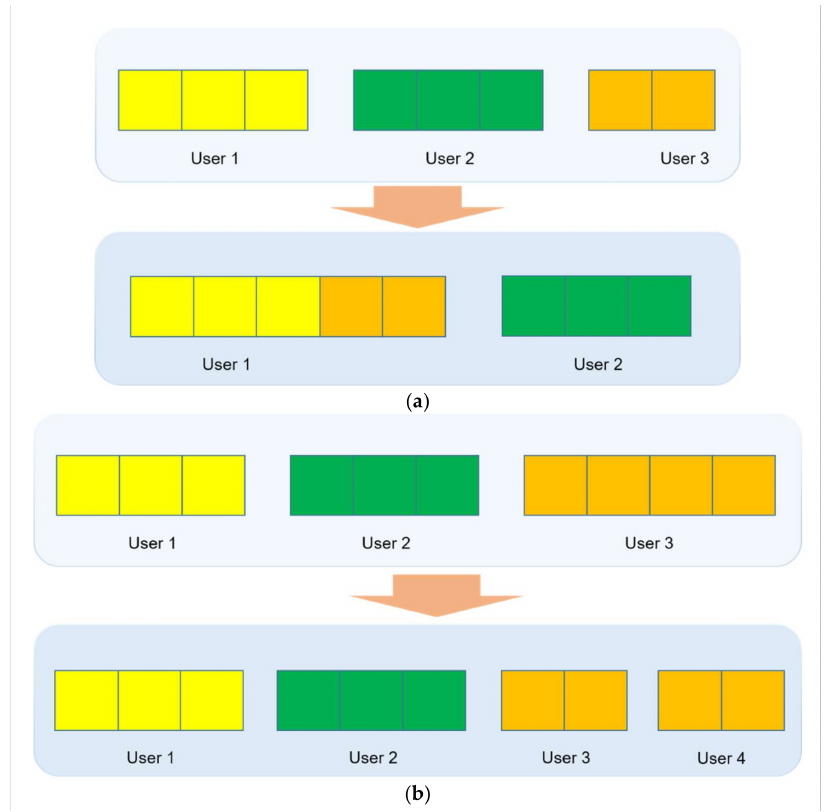
Figure 4. Corresponding scenarios for Constructions ( a ) A and ( b ) B.